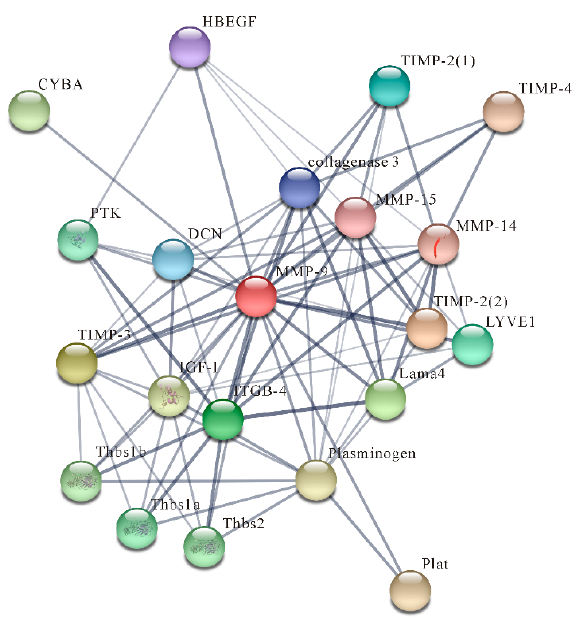
Figure 3. A network of protein–protein interactions created by NtMMP-9 and other proteins. Biomolecules 2019 , 9 , x FOR PEER REVIEW